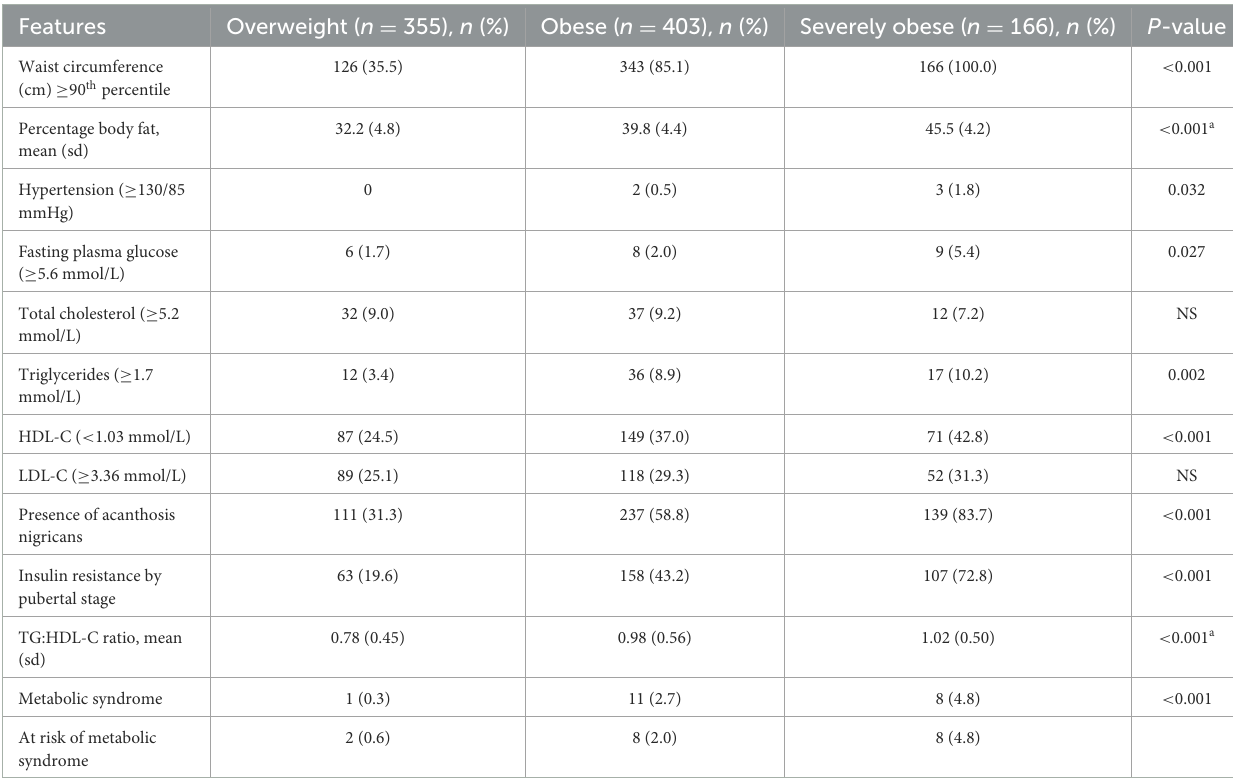
TABLE 3 Prevalence of cardiometabolic risk factors by obesity